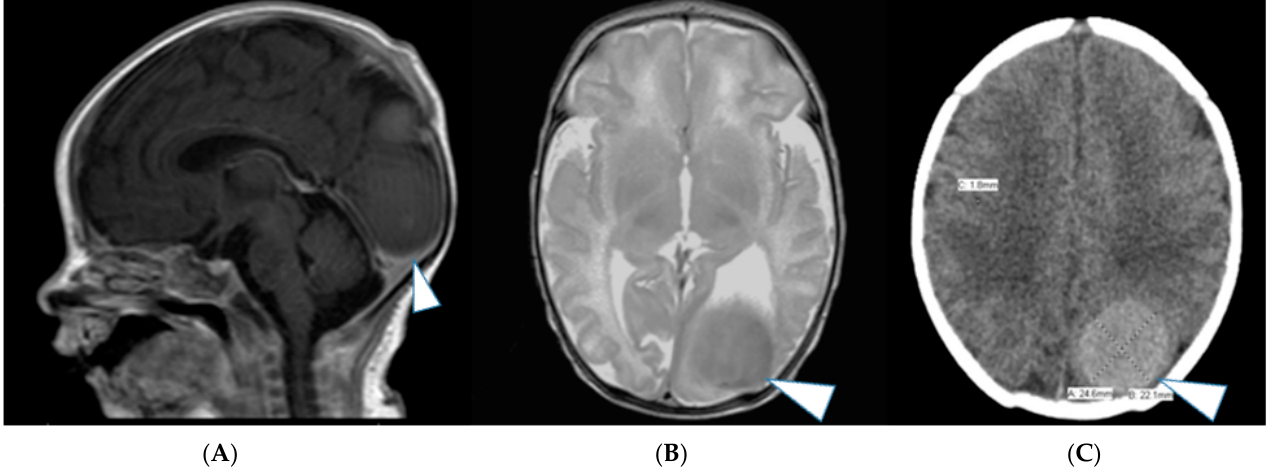
Figure 6. ( A – C ): Matching contrast enhanced sagittal contrast enhanced T1-weighted, axial T2- weighted and axial CT images confirm the left occipital lobe highly cellular (T2-hypointense), non- enhancing mass lesion with mild hyperdensity due to the high cellularity compatible with a neuroglial tumor (arrowhead).